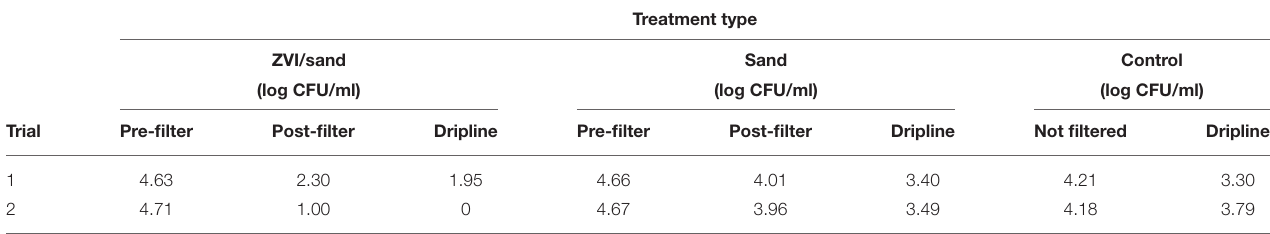
TABLE 5 | Summary of E. coli TVS 353 levels inoculated into autoclaved pond water (pre-filter), recovered after ZVI-sand and sand filtration (post-filter), or control (not